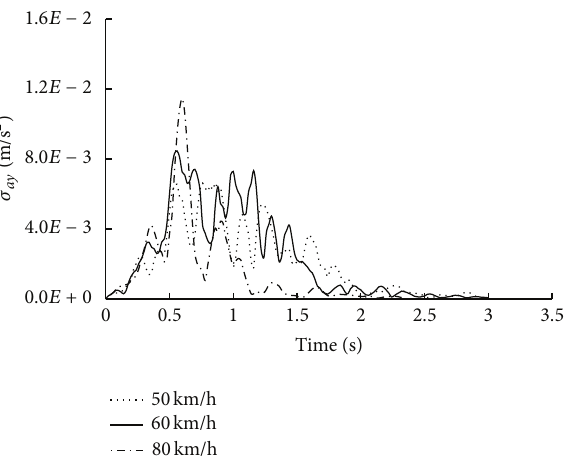
Figure 14: Mean acceleration of vehicle at C.G.